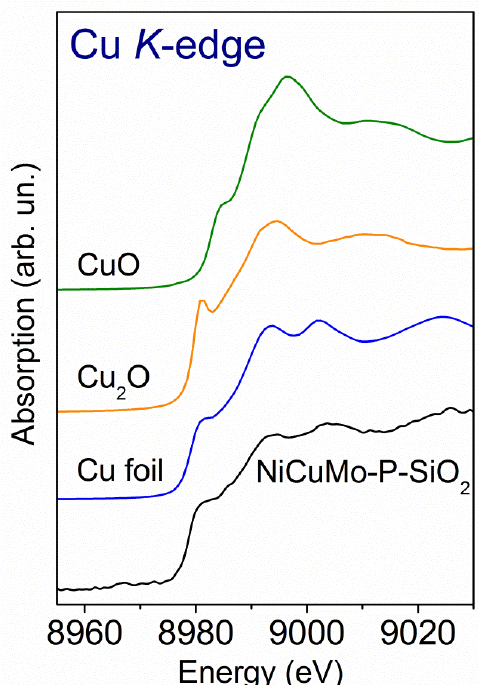
Figure 6. Cu K-edge XANES spectra for NiCuMo-P-SiO 2 catalyst after additional in situ reduction at 400 °C, in comparison to Cu foil, Cu 2 O, and CuO standards.